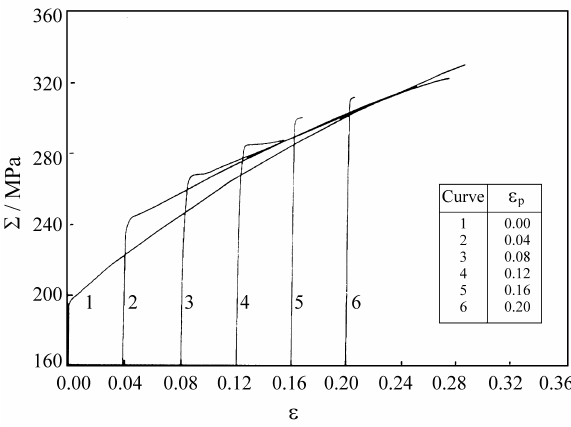
Figure 1. Examples of true stress ( σ ) - true strain ( ε ) curves in tension of samples prestrained in rolling. The curve without prestrain ( ε p = 0) is also shown.